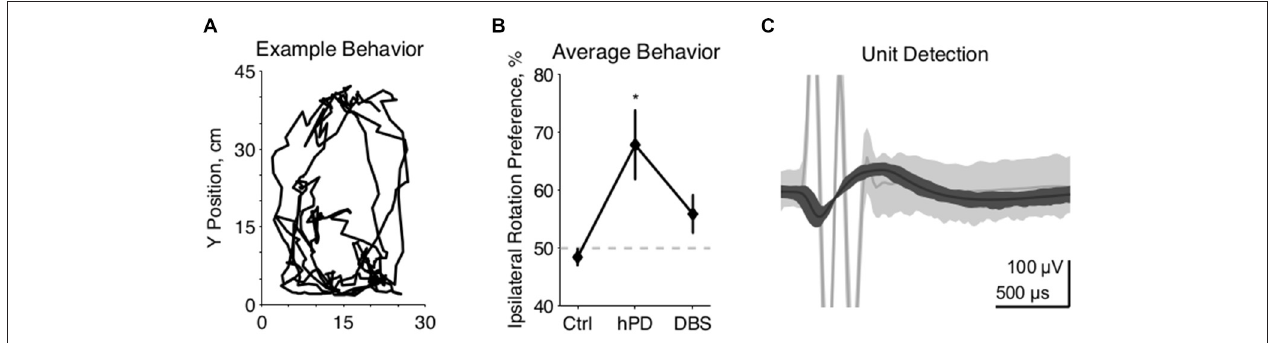
percentage, mean ± SE. Asterisk denotes statistically significant difference from 50% ( p t - test < 0.05). Lesioned rats rotate preferentially ipsilateral to injection, and are thus classified as hemiparkinsonian (hPD). (C) Representative example of a neuronal spike unit ( dark gray ) sorted separately from a DBS artifact ( light gray ), with center lines showing the average waveforms of both